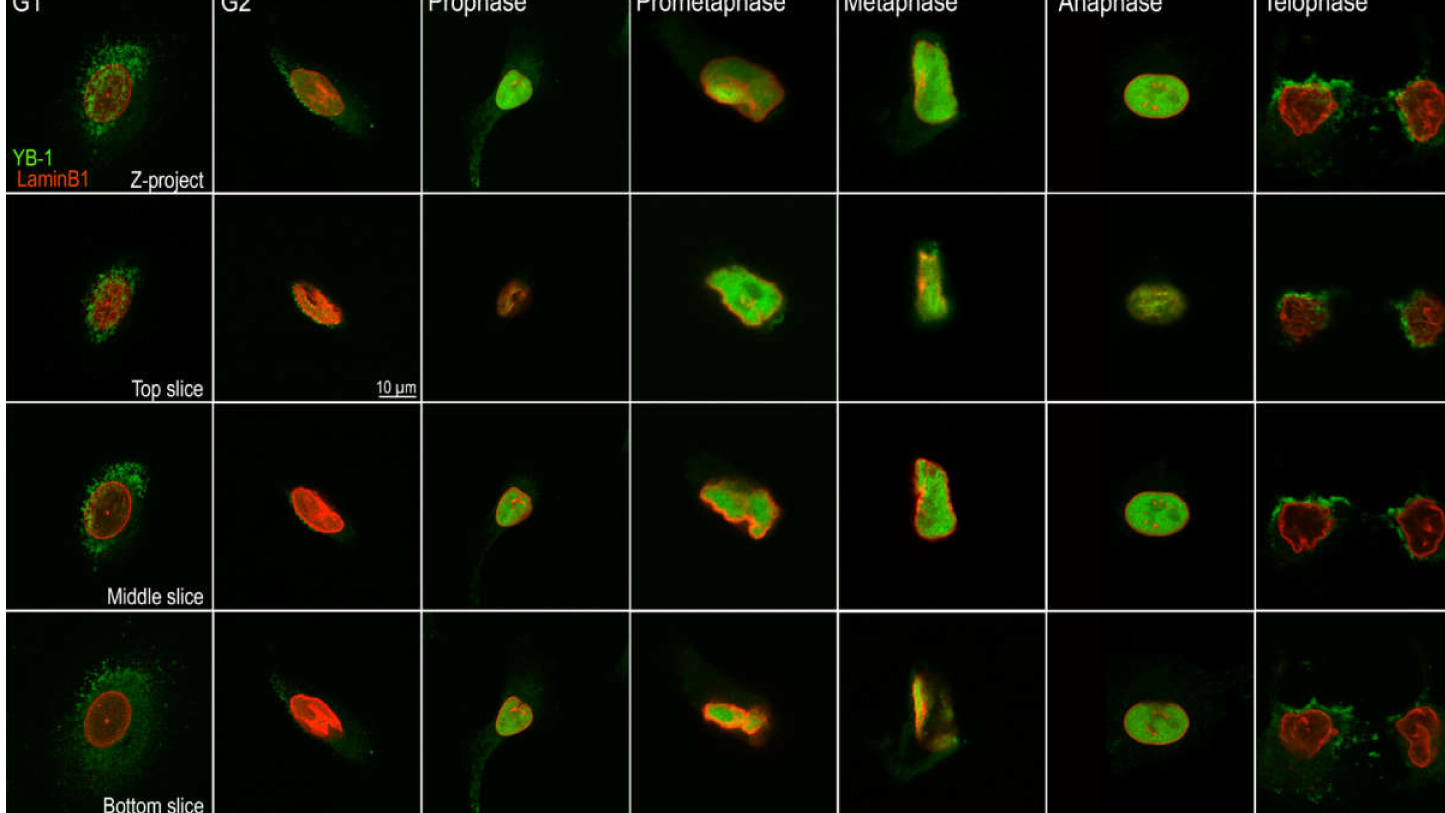
Figure 4. Cellular location of YB-1 is dependent on cell cycle phase. The top row are z-projections of 0.2 µ m slices of synchronised A549 cells at sequential phases of the cell cycle. The second row shows the top slice, the third row shows the middle slide and the last row shows the bottom slices of each stack respectively. YB-1 (shown in green) is cytoplasmic in G 1 , becomes increasingly perinuclear during G 2 and moves into the nucleus during prophase and remains there until telophase when it appears to be outside the nucleus. Lamin B1 is shown in red. Scale bar: 10 µ